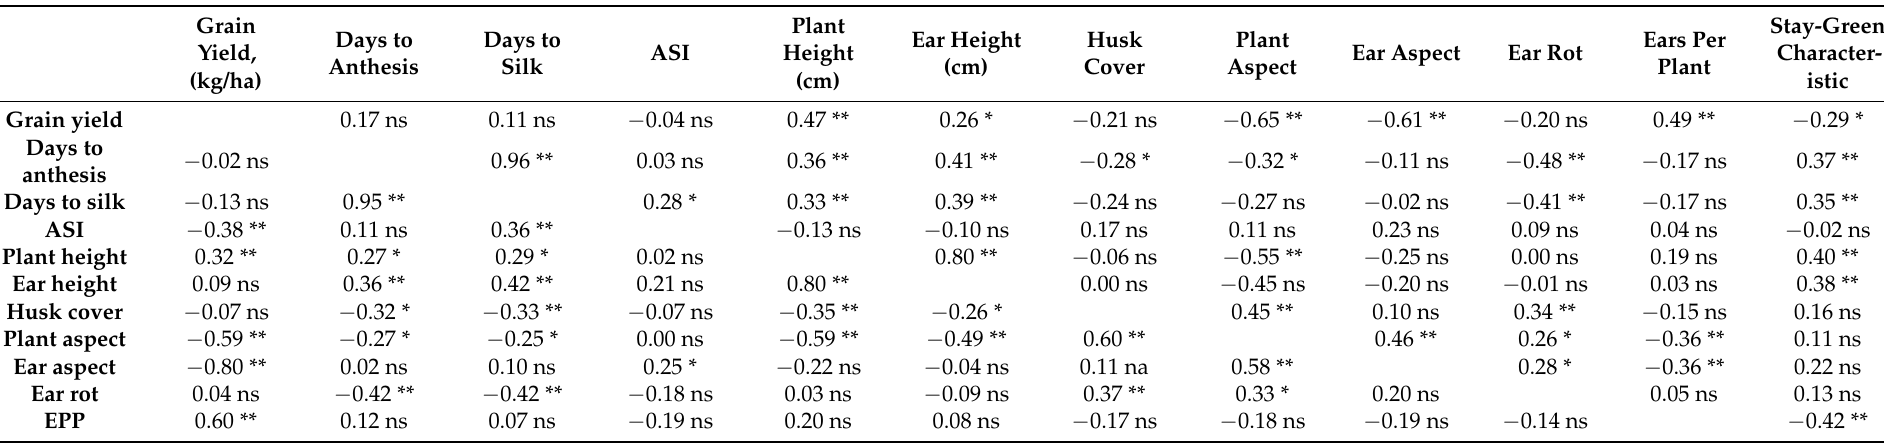
Table 4. Correlation coefficients of grain yield and other agronomic traits of early-maturing maize hybrids evaluated in four low N environments (above diagonal) and five high N environments (below diagonal) in Nigeria from 2017 to